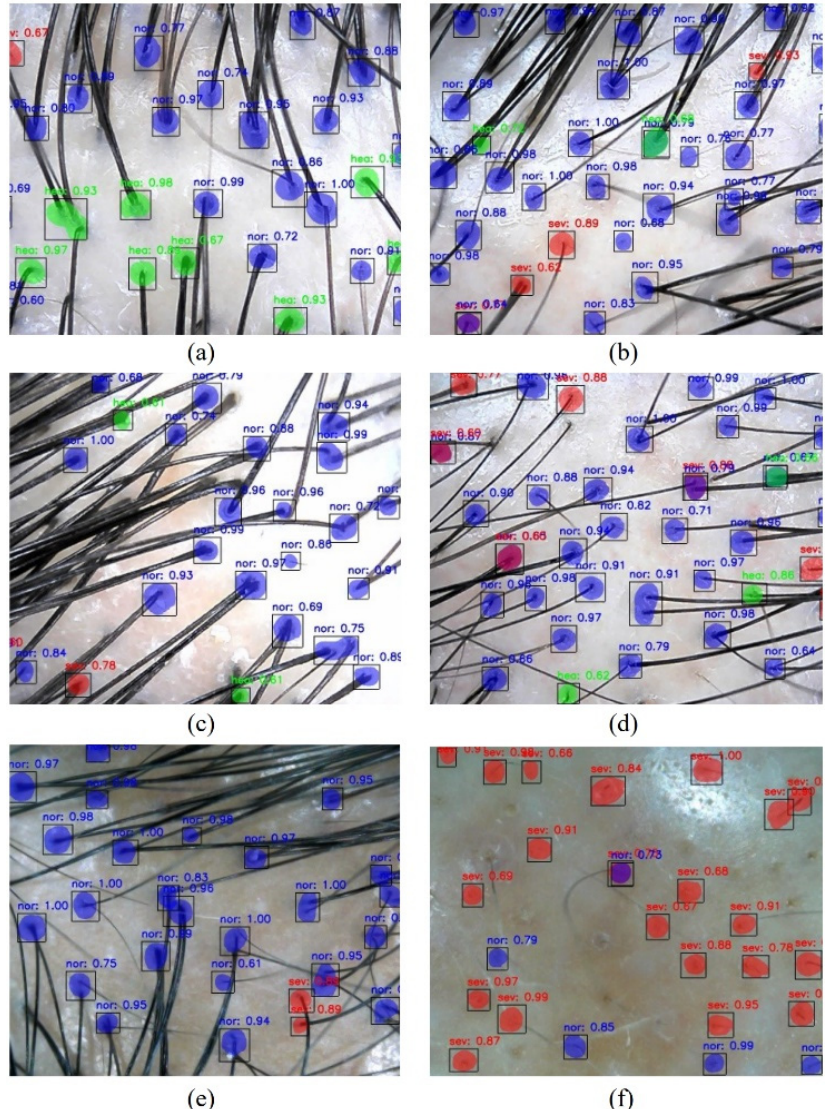
Figure 3. Test results of the trained Mask R-CNN with ResNet model as a feature extractor, where red circles indicate severe label, blue circles indicate normal label, and green circles indicate healthy label. Purple circles are due to different classifications of two very adjacent hair follicles, severe and normal. From healthy to severe hair loss classes are shown respectively from ( a – f ).